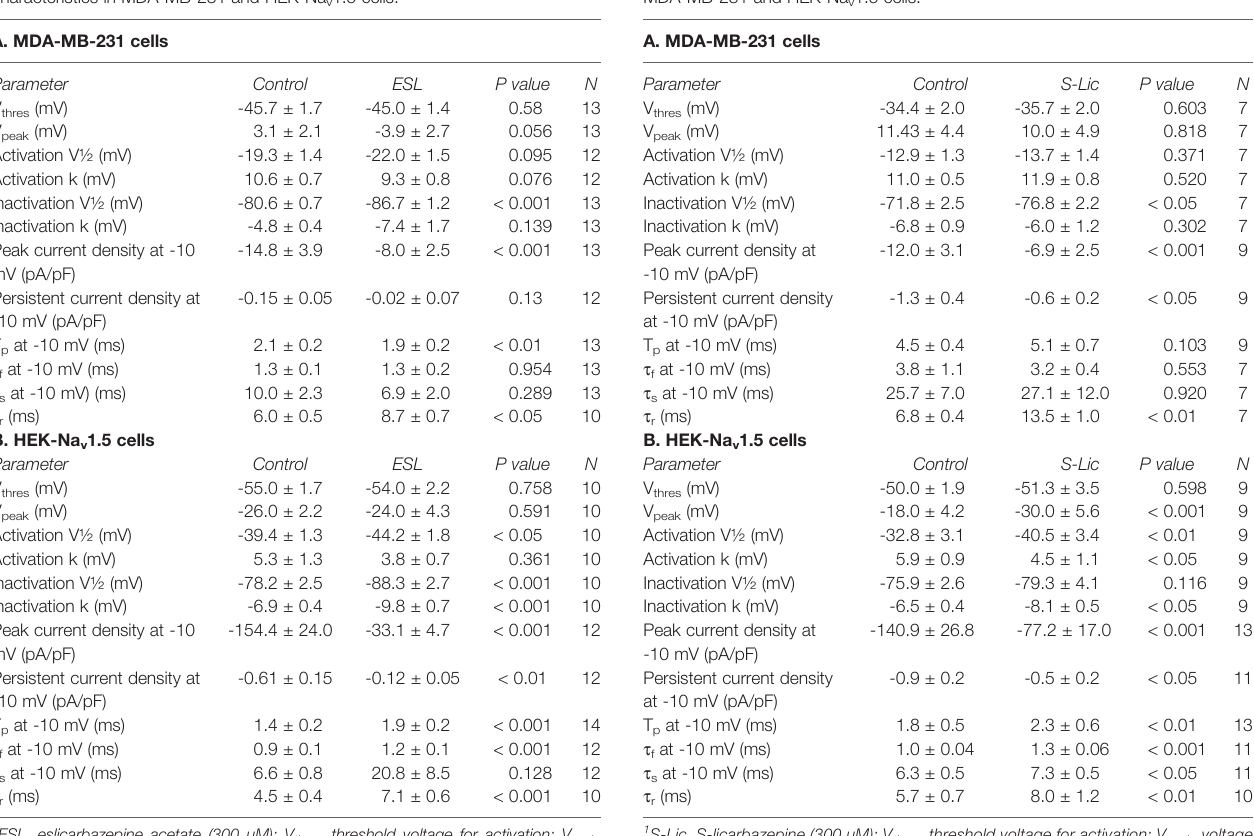
TABLE 1 | Effect of eslicarbazepine acetate (300 m M) on Na + current characteristics in MDA-MB-231 and HEK-Na v 1.5 cells. 1